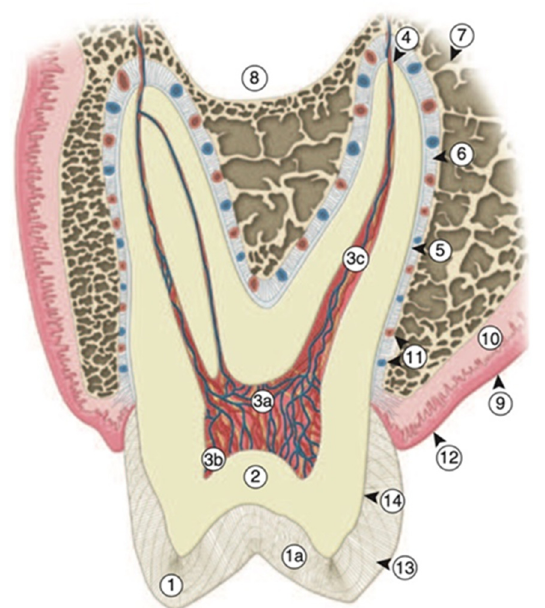
Figure 1. A cross-section of a tooth showing structural features of natural dental tissues; ( 1 ) Enamel; ( 1a ), gnarled enamel; ( 2 ) dentin; ( 3a ) pulp chamber; ( 3b ) pulp horn; ( 3c ) pulp canal; ( 4 ) apical foramen; ( 5 ) cementum; ( 6 ) periodontal ligament; ( 7 ) alveolar bone; ( 8 ) maxillary sinus; ( 9 )